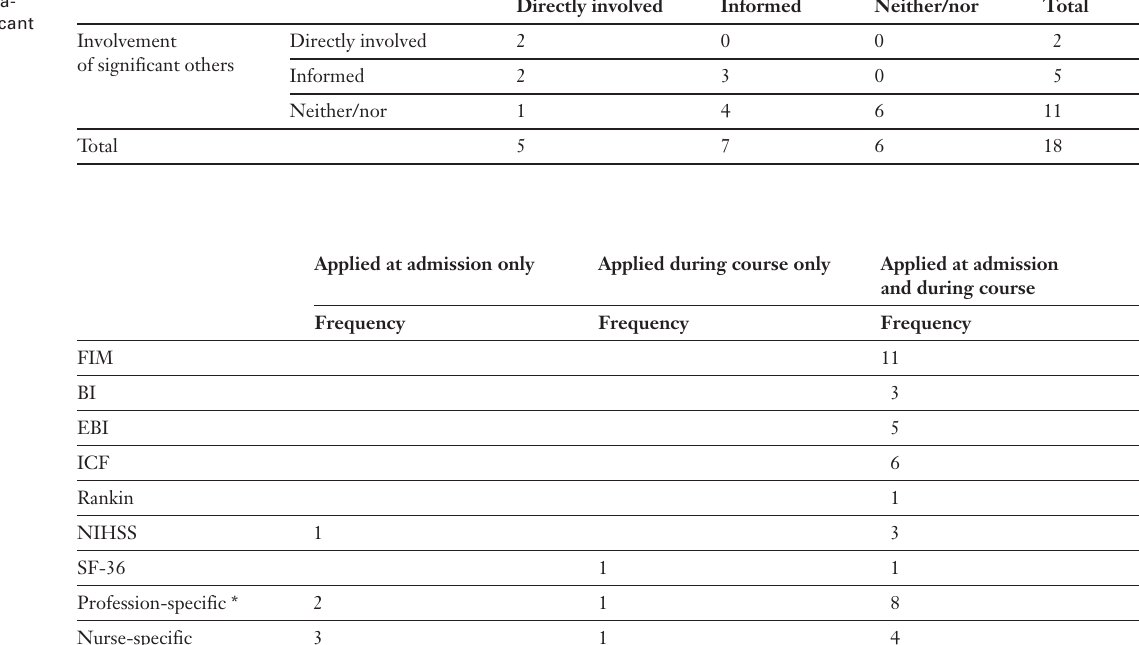
Involvement of pa- tients and significant others.